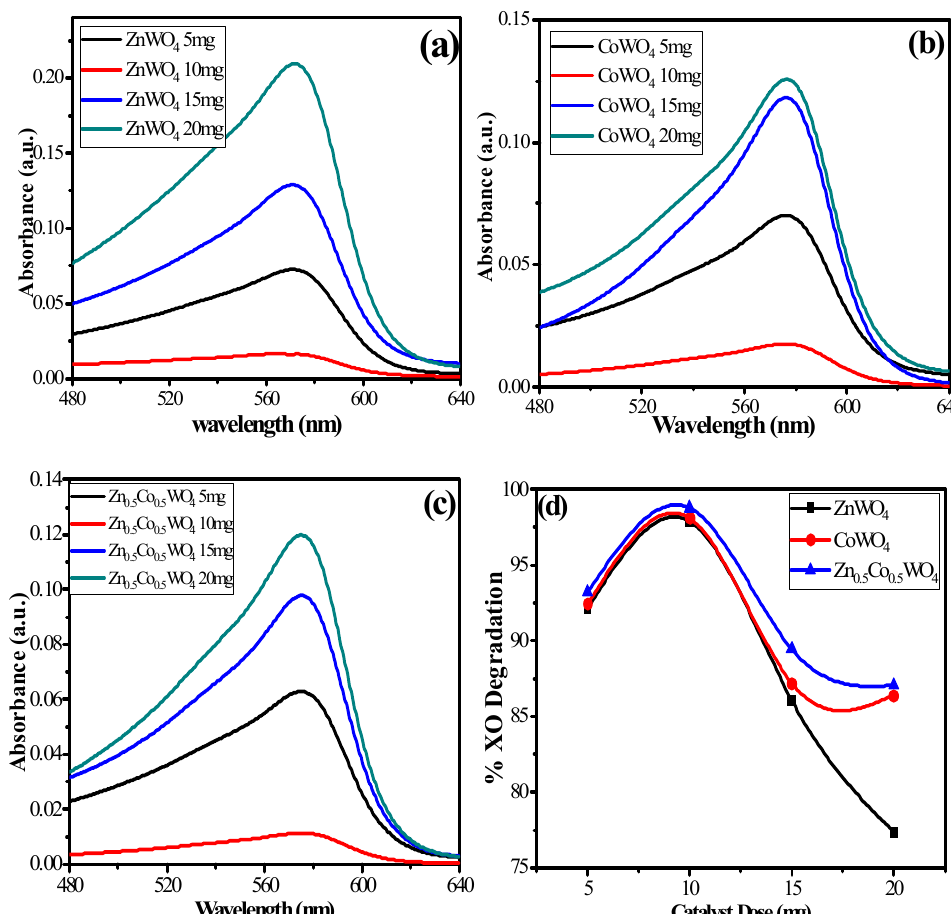
Figure 8. Photocatalytic degradation of XO with a different catalytic dose of ( a ) ZnWO 4 ; ( b ) CoWO 4 ; and ( c ) Zn 0.5 Co 0.5 WO 4 ; and ( d ) %degradation vs. catalyst dose